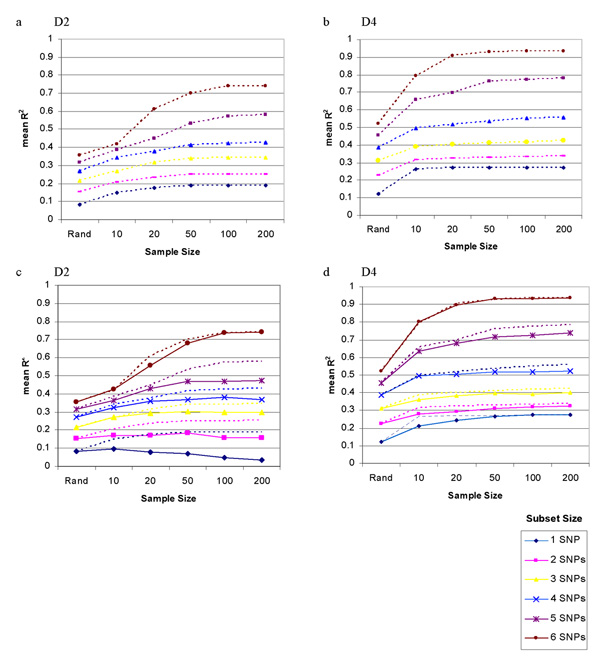
The effect of sample size on optimal subset selection at D2 and D4 using R2 (a and b), and Sε and R2 (c and d). a and b, the optimal subsets are identified from a sample using R2. They are rated using the R2 results obtained from 5,000 individuals. c and d, the optimal subsets are identified from a sample using Sε. They are rated using the R2 results obtained from 5,000 individuals. The R2 graphs are shown as broken lines for comparison.